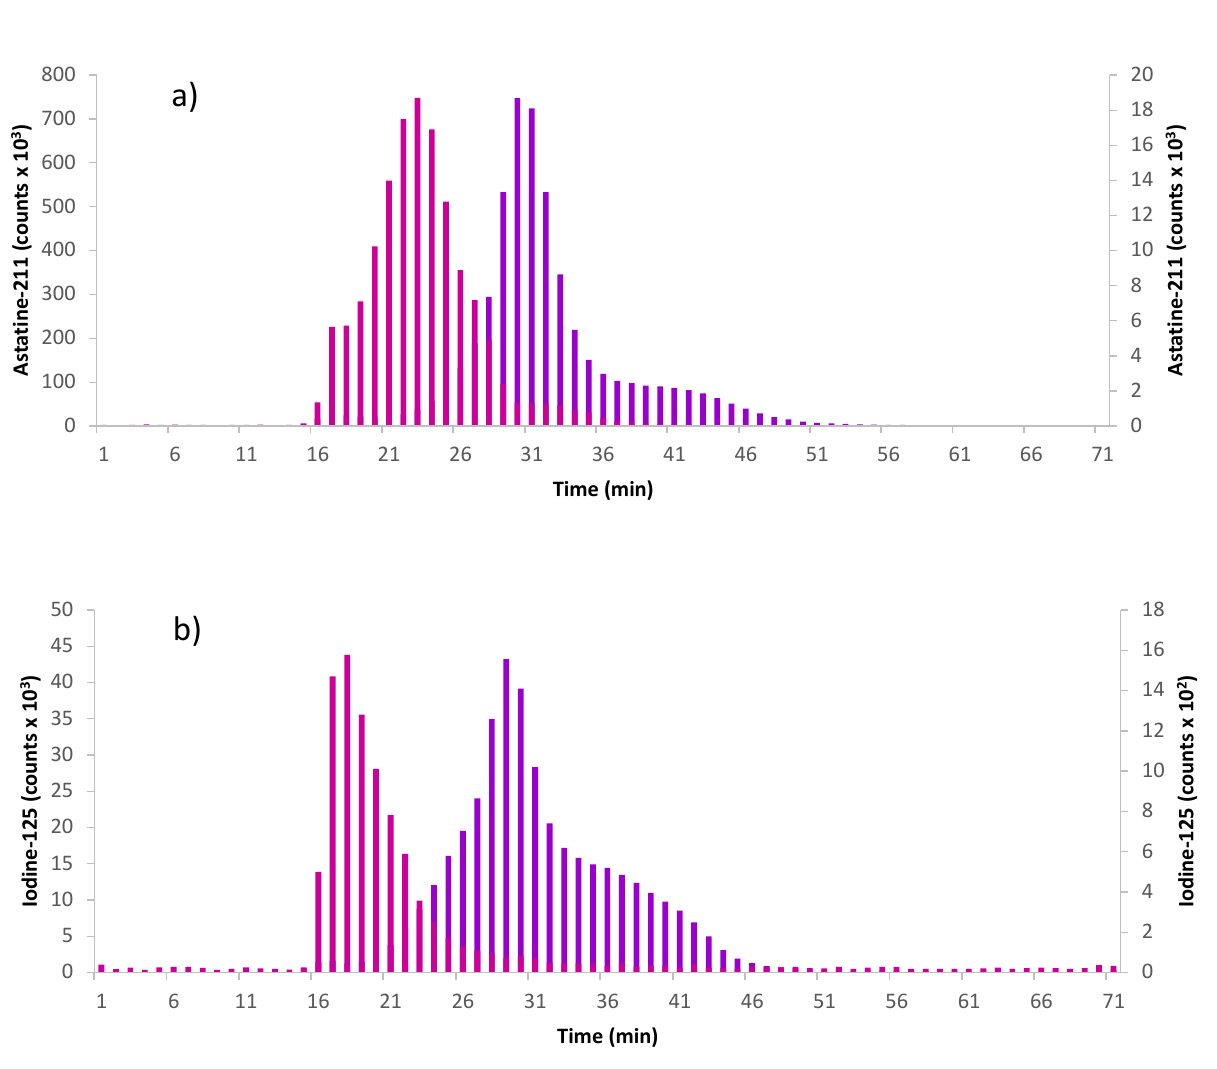
Figure 6. Radioactivity distribution after fast protein liquid chromatography (FPLC) fraction collec- tion of the radiolabeled effector molecules (violet) and the click products (pink) between effector and pretargeting agent. Top panel ( a ) shows astatine-labeled 10 kDa polymer with a click reaction time of 1.5 h and the bottom panel ( b ) shows iodine-labeled 21 kDa polymer with a click reaction time of 1 h.